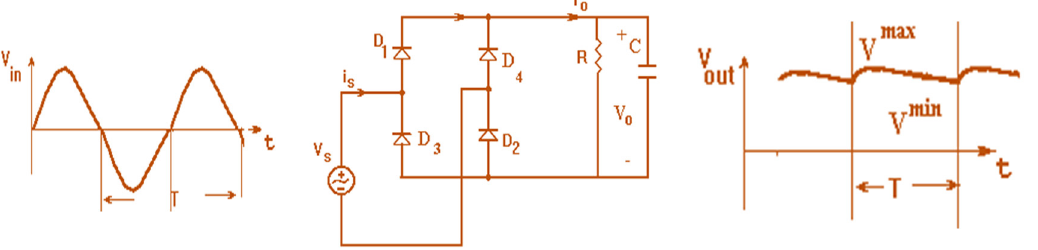
Figure 30. Diode Bridge rectifier, full wave, with a shunt capacitor.